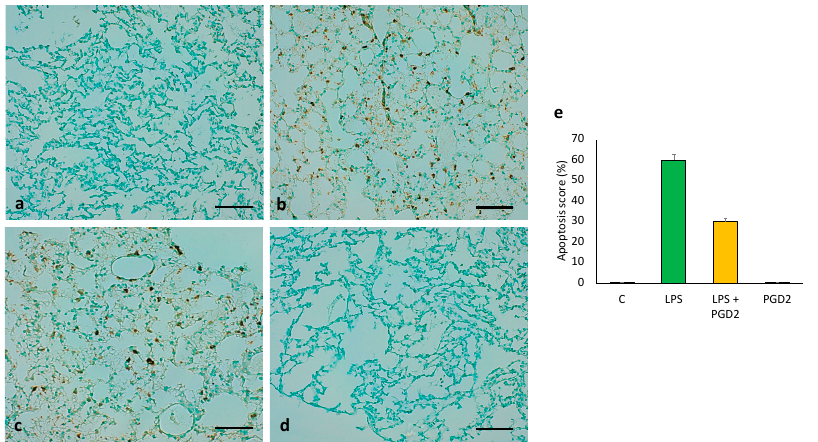
Figure 8. The therapeutic effect of PGD 2 was analysed through the measurement of apoptosis by TUNEL assay: ( a ) the control group showed no brown-stained nuclei; ( b ) LPS-intoxicated (5 mg/kg b.w.) animals showed a significant number of brown-stained nuclei; ( c ) the animals treated with PGD 2 (100 µ g/kg b.w.) prior to LPS treatment displayed a significant decrease in apoptosis; ( d ) in the animals receiving PGD 2 only, no brown-staining nuclei were observed; ( e ) percentage of apoptosis in different groups. (Scale bar = 100 µ